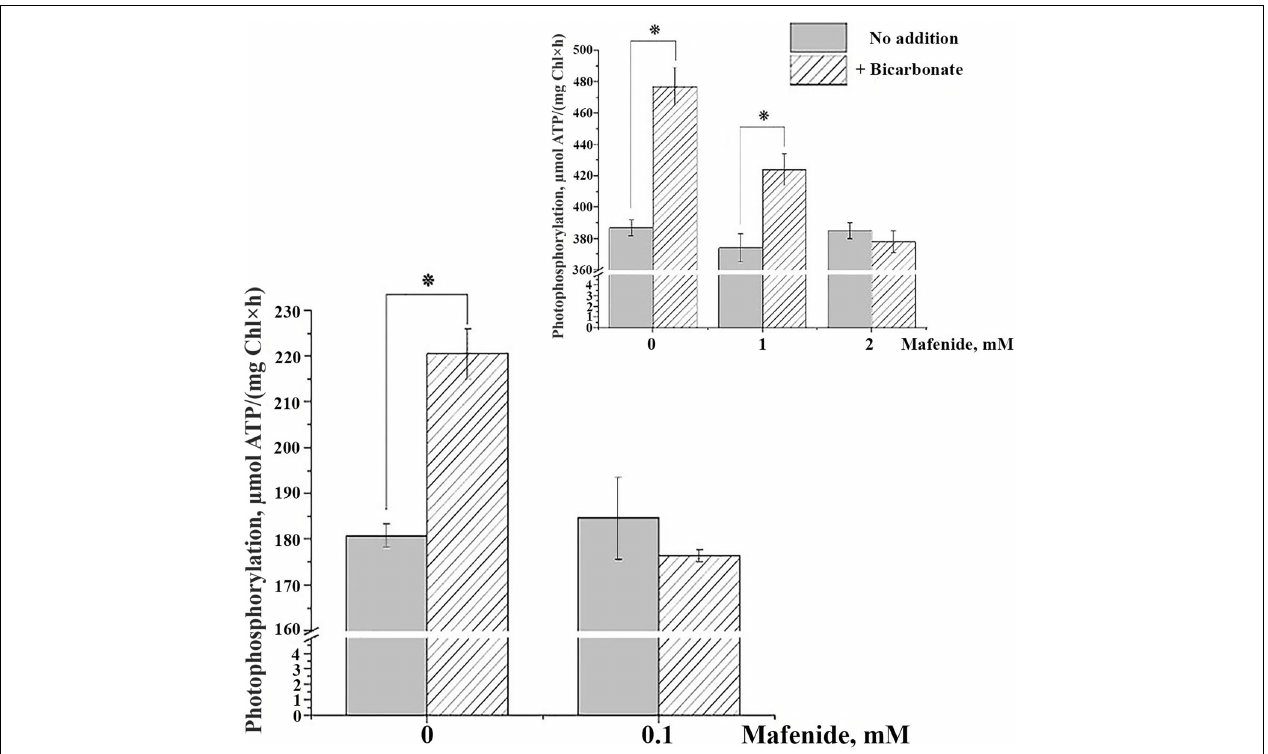
FIGURE 1 | Effect of bicarbonate and mafenide on the rate of photophosphorylation (PP) in thylakoids from Arabidopsis thaliana plants (main panel) and from Pisum sativum (inset). The data for thylakoids from P. sativum are reproduced from Fedorchuk et al. (2018) with modifications. HCO 3 − was present in the reaction mixture at concentration of 4 mM; mafenide was added at the concentrations indicated on the Y -axis. For detailed conditions of the experiments, see “Materials and Methods” section. Data are given as mean values ± SD ( n = 6). Similar results were obtained with thylakoids isolated from plants of three independent plantings. * Statistically significant differences ( P < 0.01).